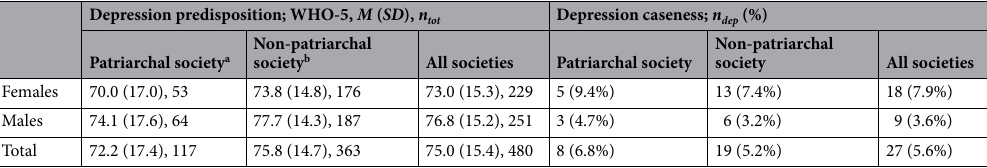
Table 1. Predisposition to depression (mean WHO-5 score) and depression caseness (WHO-5 score < 50) among participating adolescent Athletics athletes (n = 480) displayed by sex and society. M mean, SD standard deviation, n tot number of athletes, n dep number of athletes with caseness depression (WHO-5 < 50). 26 athletes excluded due to missing data on more than one WHO-5 item. a Asia, Africa, b Europe, the Americas, Oceania.